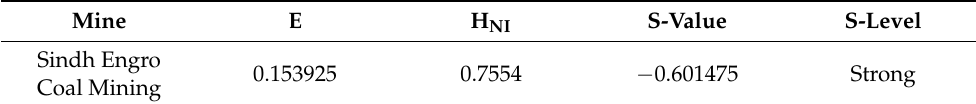
Table 6. Environmental